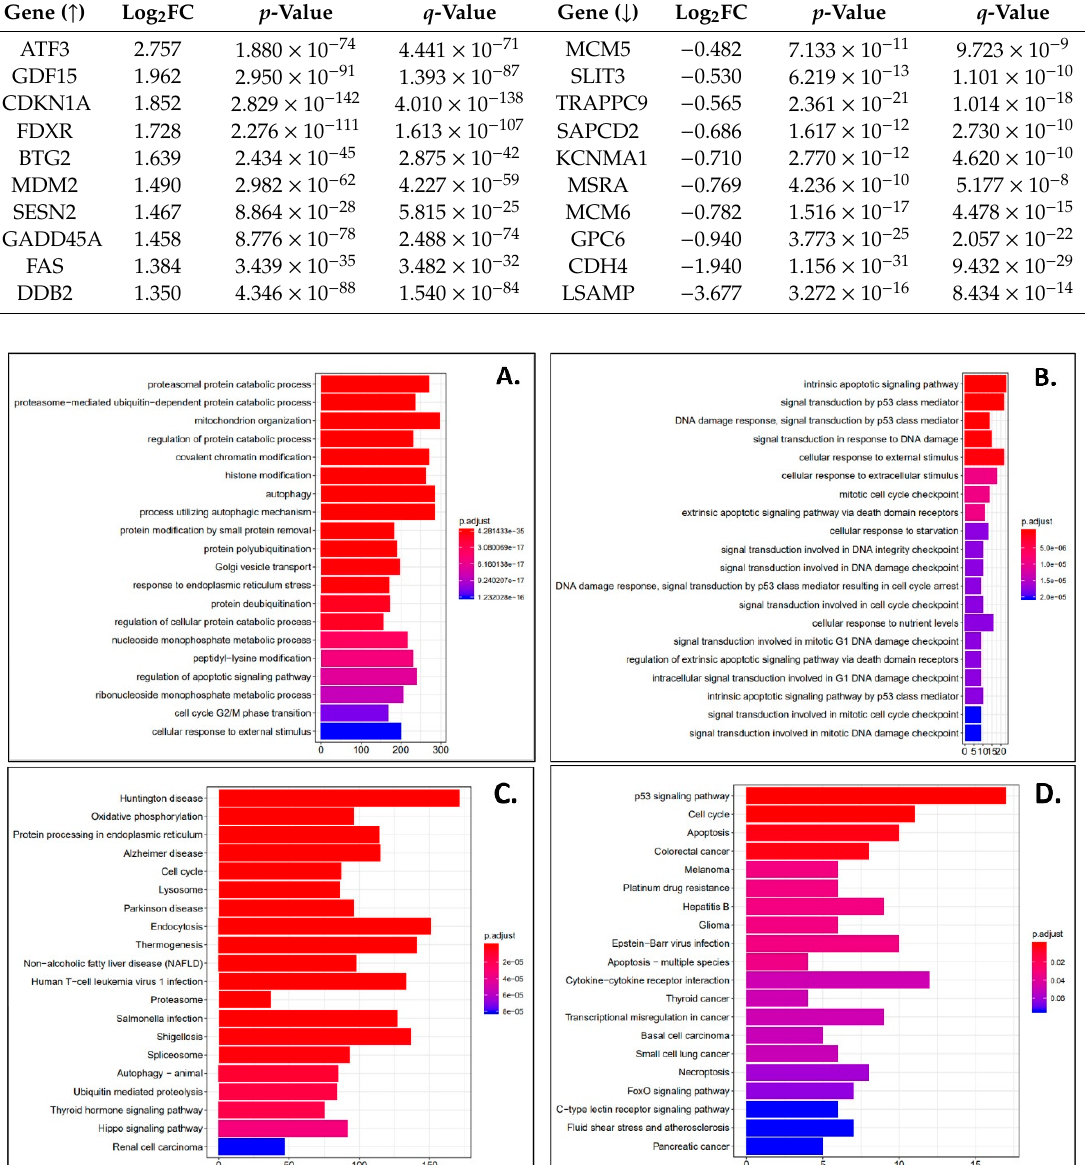
Figure 3. Phenanthriplatin and cisplatin modulate cellular pathways in A549 cells. ( A ) The top 20 enriched GO biological processes for the A549 phenanthriplatin versus A549 control comparison. ( B ) The top 20 enriched GO biological processes for the A549 cisplatin versus A549 control comparison. ( C ) The top 20 enriched KEGG pathways for the A549 phenanthriplatin versus A549 control comparison. ( D ) The top 20 enriched KEGG pathways for the A549 cisplatin versus A549 control comparison. The x-axes show the number of DEGs per GO biological process. Statistical analysis for KEGG pathway analysis is provided in the panels.